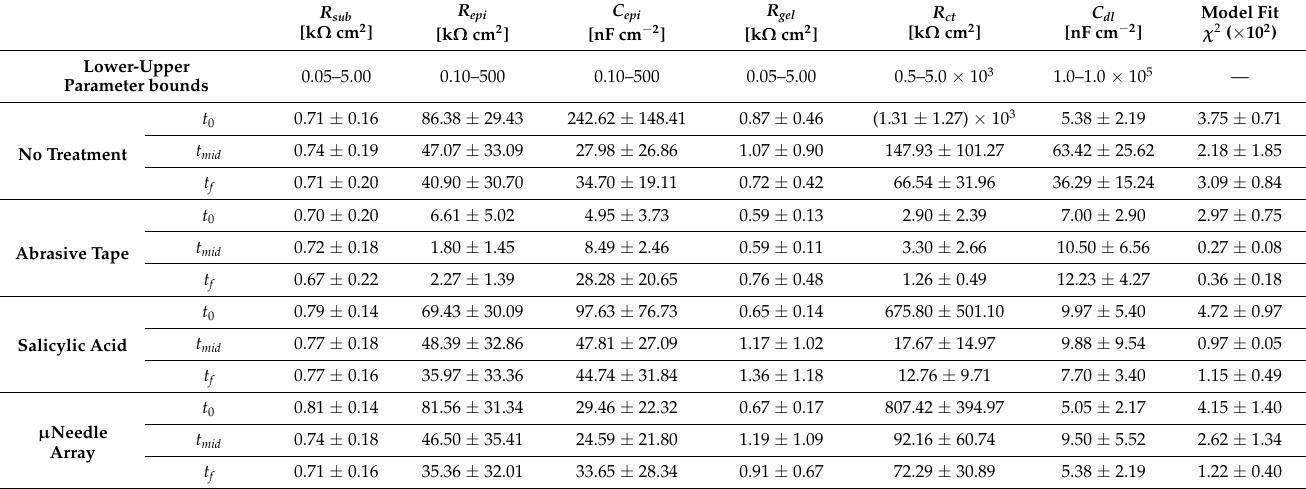
Table 1. Equivalent circuit elements, their boundaries, and average fitted values for each skin treatment, at t 0, t mid , and t f . The range for each parameter was determined based on values in literature [4,17], as well as considering the total impedance (see Equation (1) and Figure 2b). Values are reported as avg. ± std. dev. across N = 14